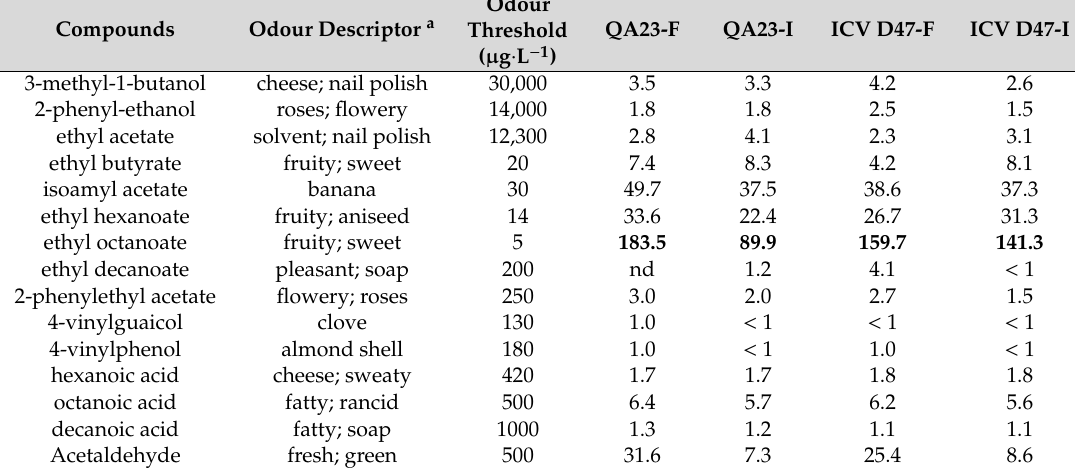
Table 4. Odor activity values (OAV) of volatile compounds of more influence on the aroma of mead fermented by S. cerevisiae QA23 and ICV D47 with free cells (F) or immobilized cells (I).